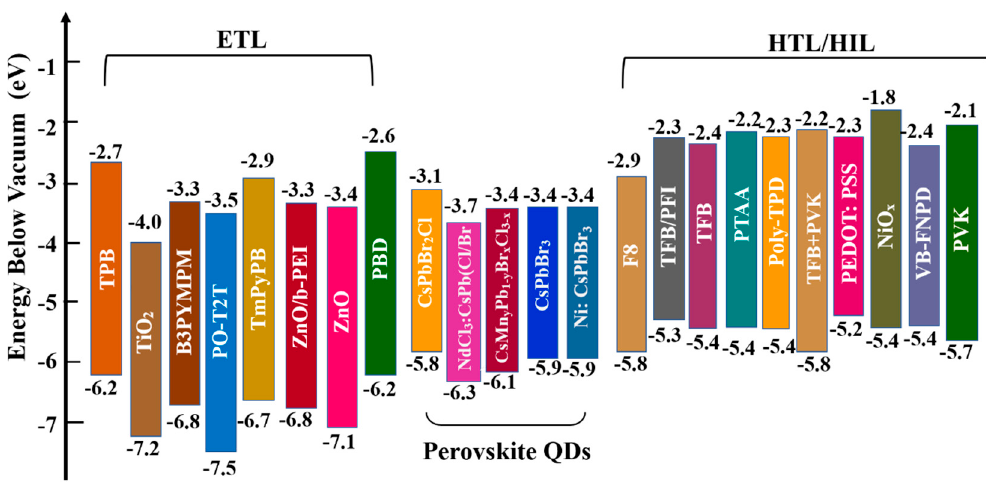
Figure 6. Energy diagram of the commonly used ETL, PQD, HTL/HIL materials in blue PQD–based LEDs.